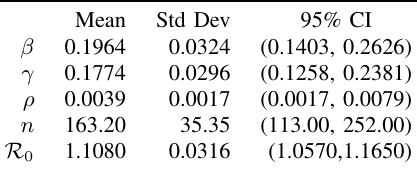
TABLE II: Results under the EVD survival model for the community outbreak only Mean Std Dev 95%